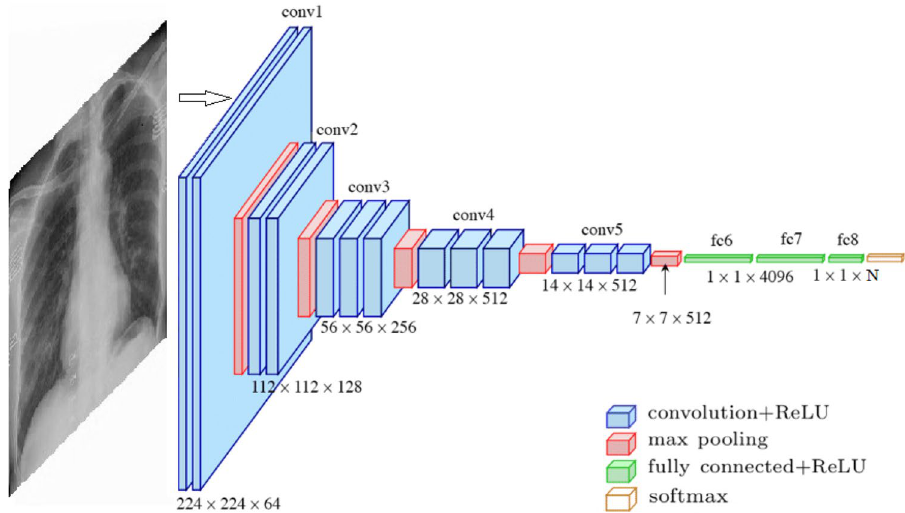
Figure 2. The structure of VGG16 model.This figure was created with Image online.co and exported under a free